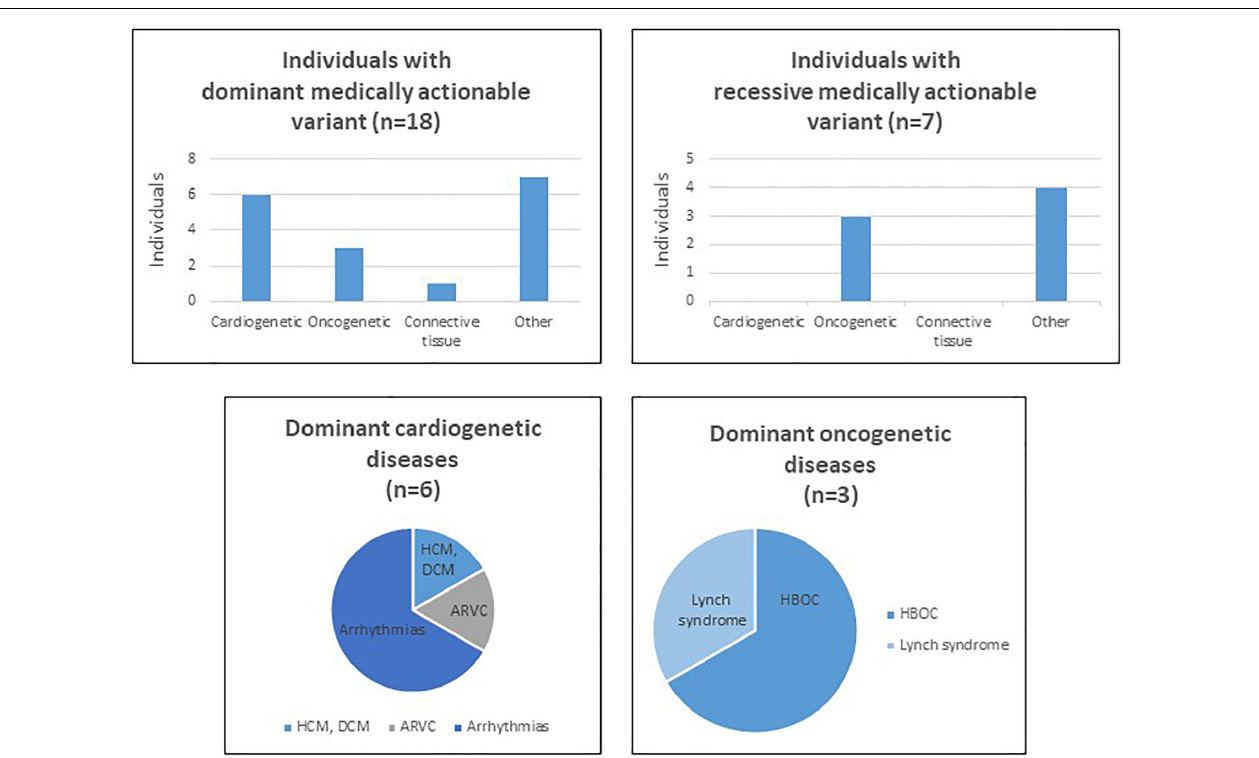
FIGURE 1 | Charts and tables summarizing secondary findings in our cohort of patients. HCM, hypertrophic cardiomyopathy, DCM, dilated cardiomyopathy, ARVC, arrhythmogenic right ventricular